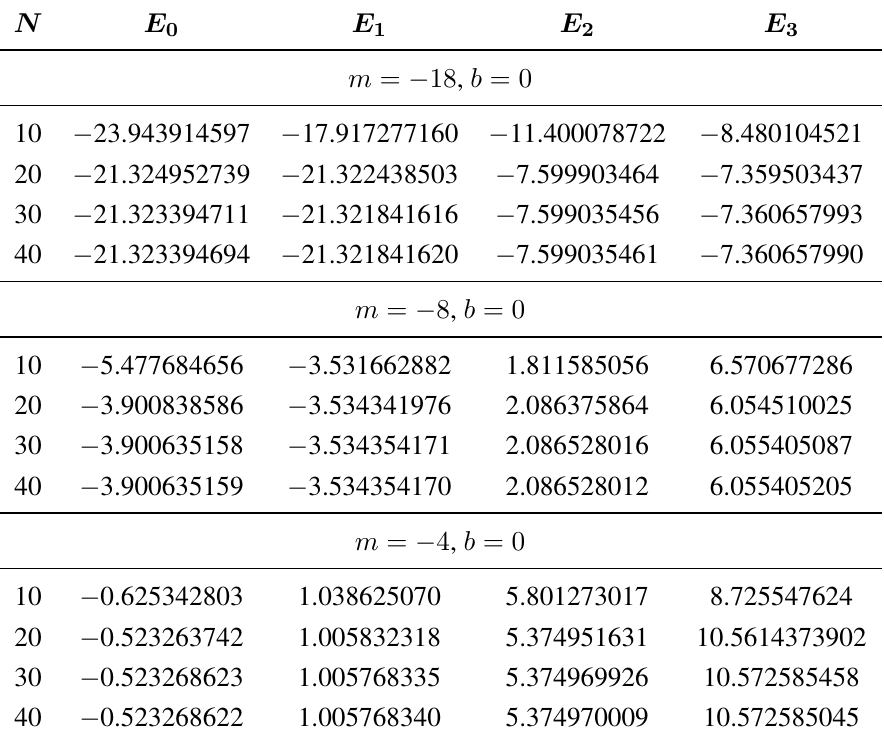
Table 1. Convergence properties for V ( x ) = mx 2 + bx 4 + x 6 using R ( x ) = e − x 4 / 4 by using the global-local